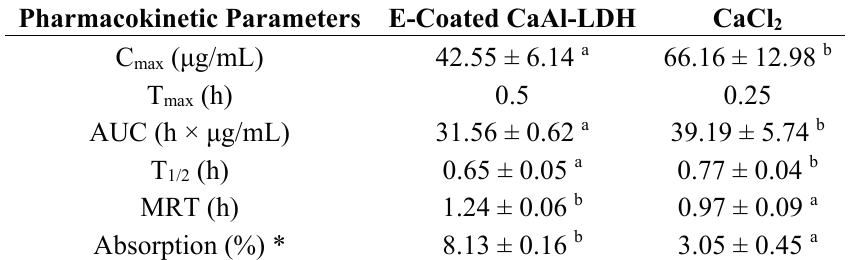
Table 4. Pharmacokinetic parameters of E-coated CaAl-LDH, as compared with CaCl 2 after a single dose oral administration to rats.